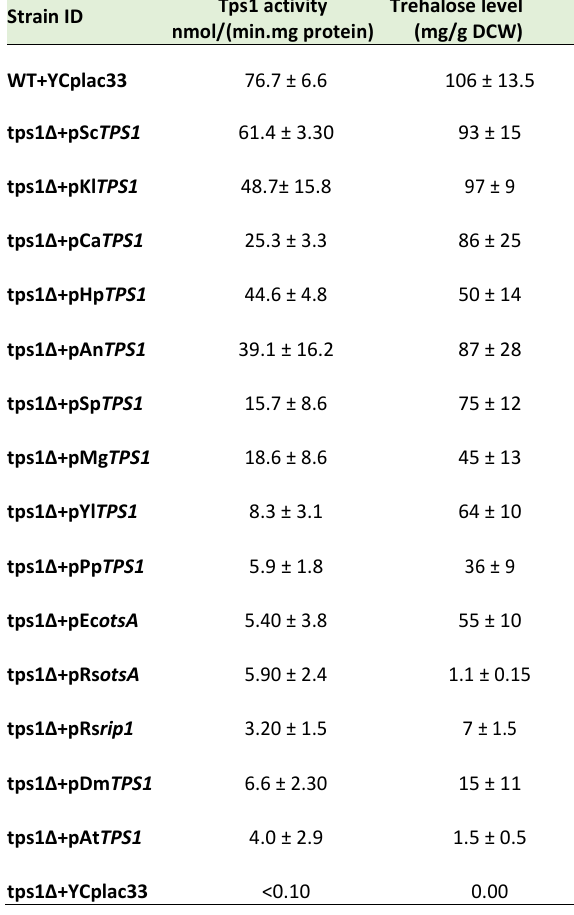
TABLE 2 . Activity of Trehalose 6-P synthase (Tps1) and levels of trehalose in the S. cerevisiae tps1 mutant transformed by TPS1 of various